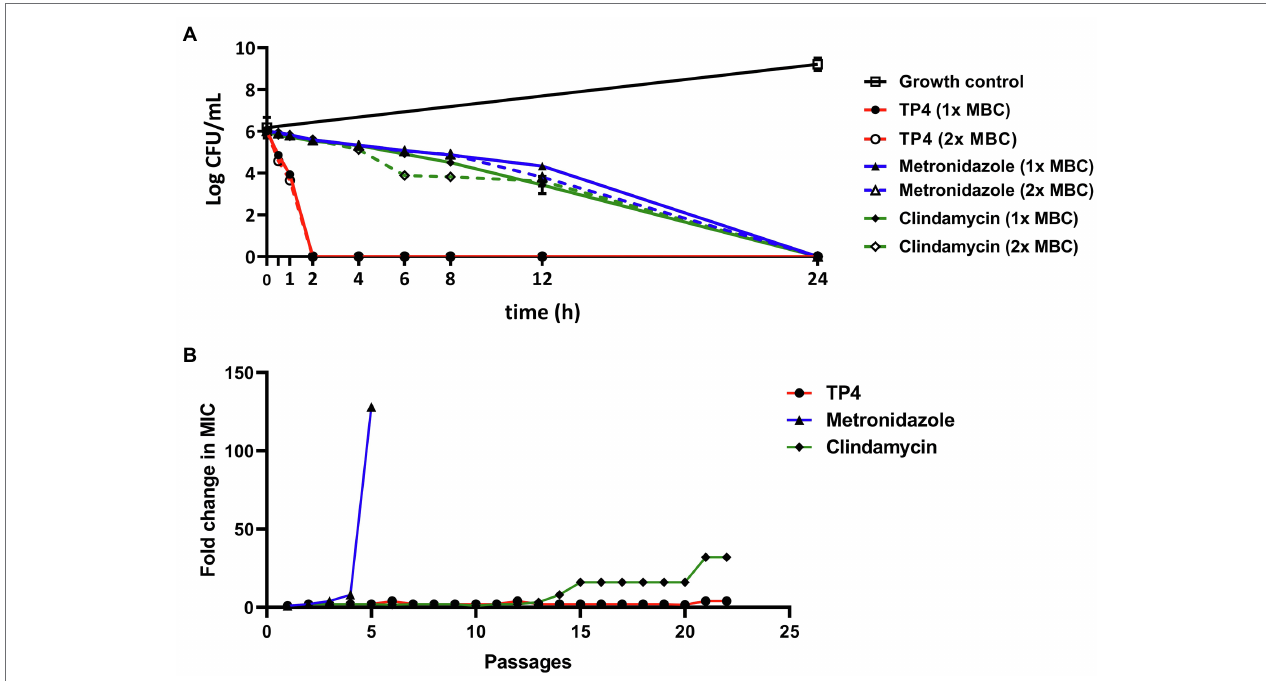
FIGURE 3 | Tilapia piscidin 4 rapidly kills and does not readily induce resistance in pathogenic Gardnerella vaginalis . (A) Representative time-kill curves for G. vaginalis exposed to TP4, metronidazole, or clindamycin at 1× MBC (7.81, 3.91, and 7.81 μ g/ml, respectively) and 2× MBC (15.63, 7.81, and 15.63 μ g/ml, respectively). The log CFU/ml for all groups were determined at time 0 and then at several time-points up to 24 h. (B) Development of resistance in G. vaginalis cells exposed to TP4, metronidazole, or clindamycin in an anaerobic environment. The Y-axis shows the fold-change in MIC compared to the first passage. All values represent the mean ± SD of three individual